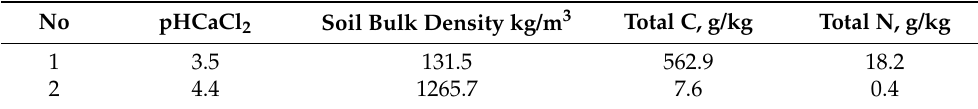
Table 2. Characteristics of soil at the studied forest stands located at two hemiboreal streams in Latvia.